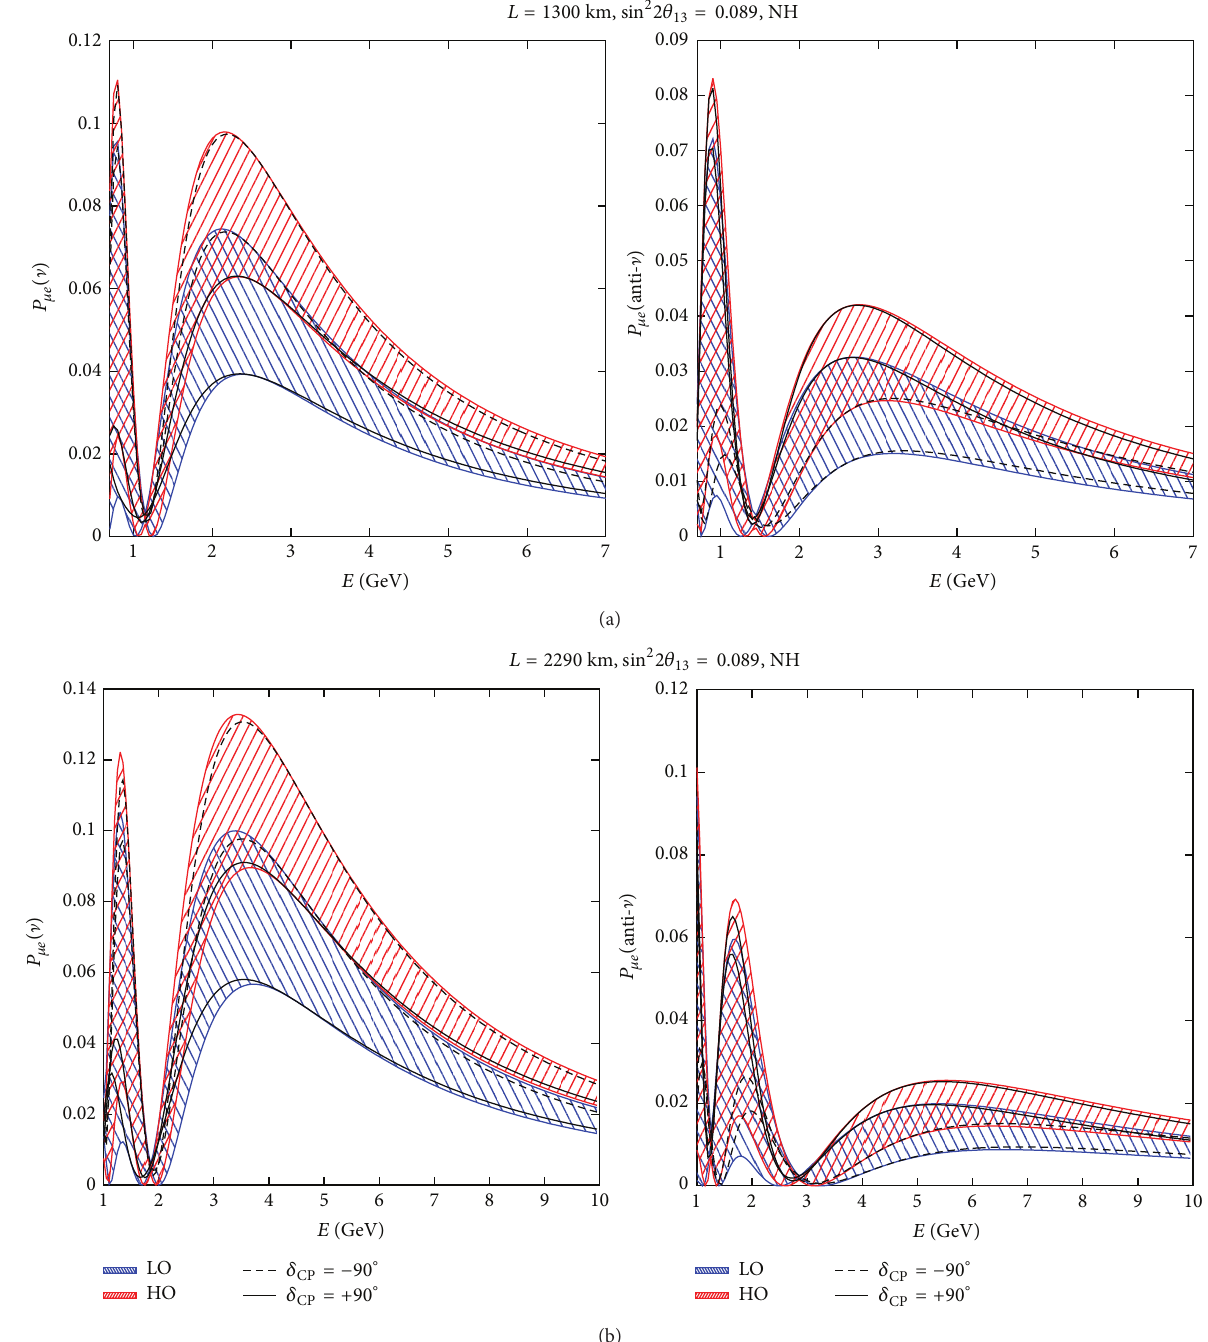
Figure 5: 𝑃 𝜇𝑒 as a function of neutrino energy. Here, the bands correspond to different values of 𝛿 = 90 ∘ ( 𝛿 = −90 ∘ ) case is shown by the solid (dashed) line. The red (blue) band is for HO with sin 2 𝜃 band, the probability for 𝛿 CP CP (LO with sin 2 𝜃 23 = 0.41 ). The left panel (right panel) is for ] ( ] ). The upper panels are drawn for the LBNE baseline of 1300 km. The lower panels are for the LBNO baseline of 2290 km. Here, we consider sin 2 2𝜃 13 = 0.089 and NH.